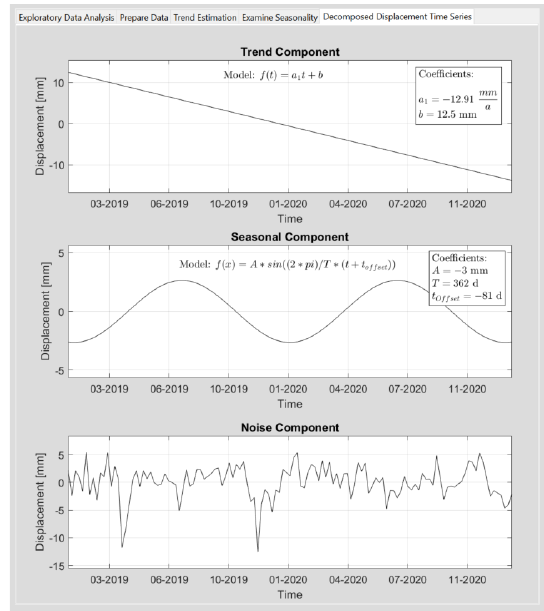
Figure 8 . The decomposed time series of PS